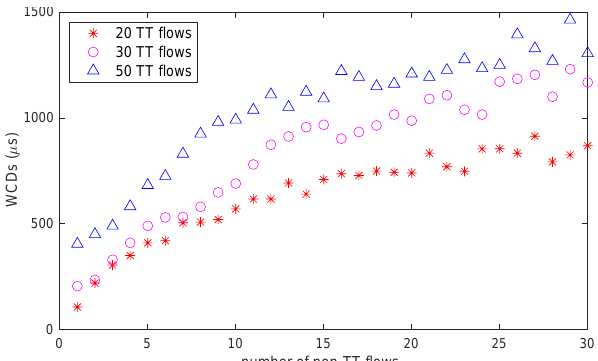
Figure 11. WCD changes with the quantity of flows participating in the